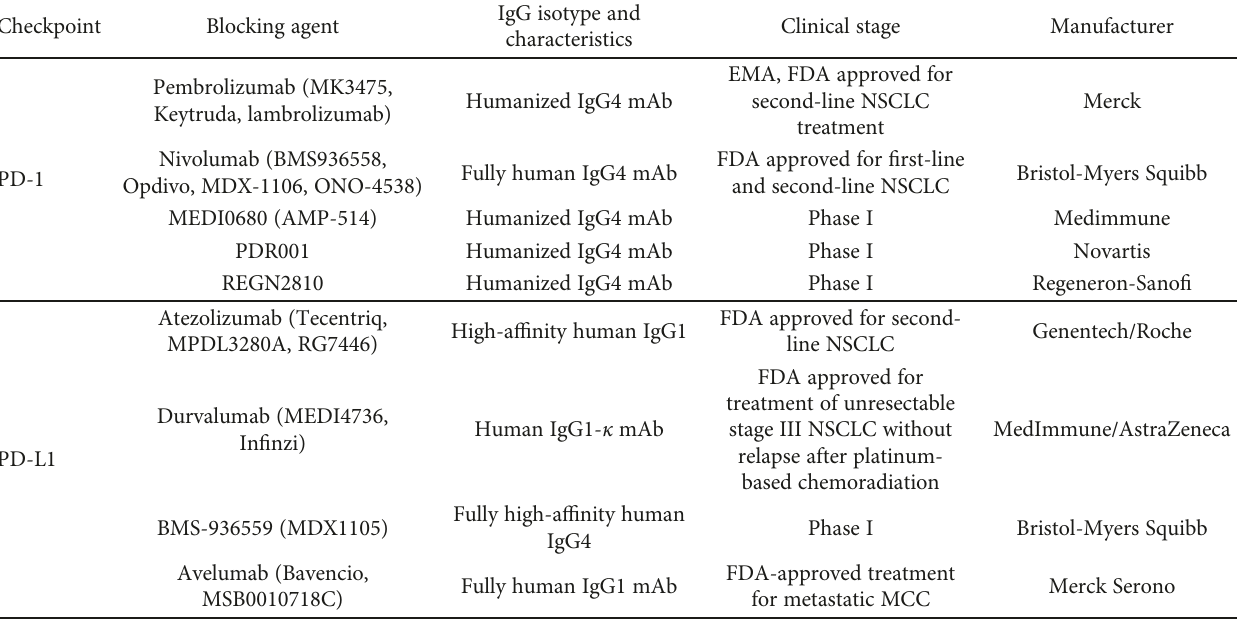
Table 1: The PD-1/PD-L1 inhibitors licensed for clinical use or under clinical trials for 1062 NSCLC treatment.